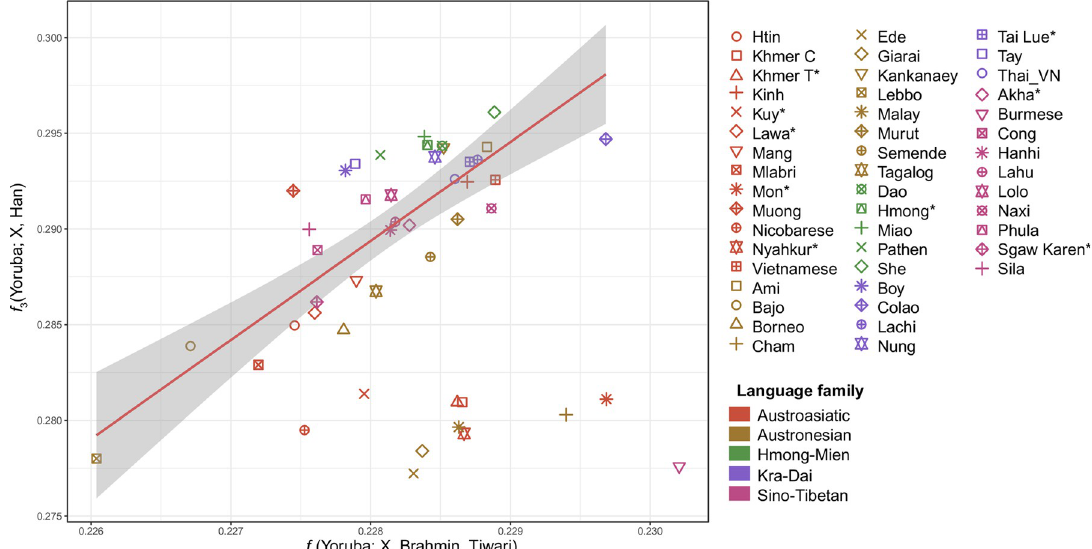
Fig 4. A biplot showing results of outgroup f -tests. The biplot of f (Mbuti; Brahmin Tiwari, X) vs. f (Mbuti; Han, X) illustrates the 3 3 3 amount of genetic drift shared between ESEA populations and Brahmin Tiwari or Han. The trend line represents a ratio of shared genetic drifts that is common for most ESEA populations. The positions of few ESEA populations deviate from the trend line, which indicates elevated shared drift between the Indian reference population and the test population, as compared to most ESEA populations. Colors of the markers represent language families. Asterisks after population names indicate that these populations are newly genotyped in this